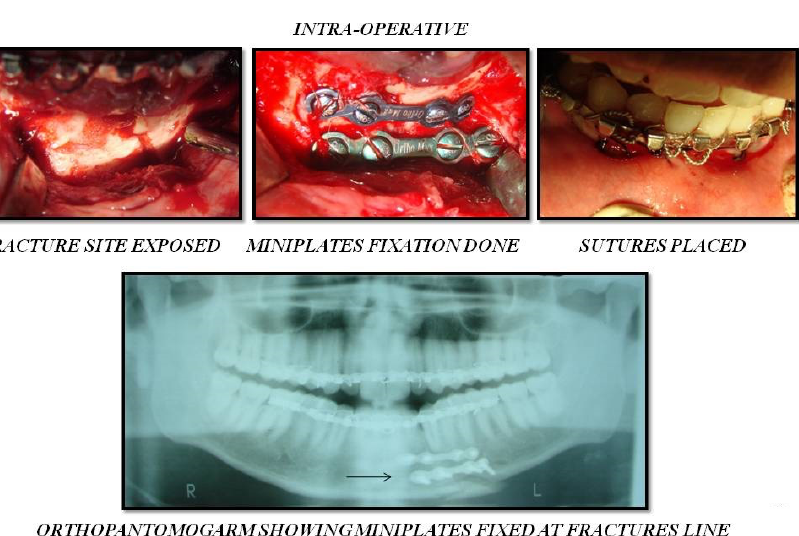
Figure 3. Case 2 – Preoperative view showing left parasymphysis fracture